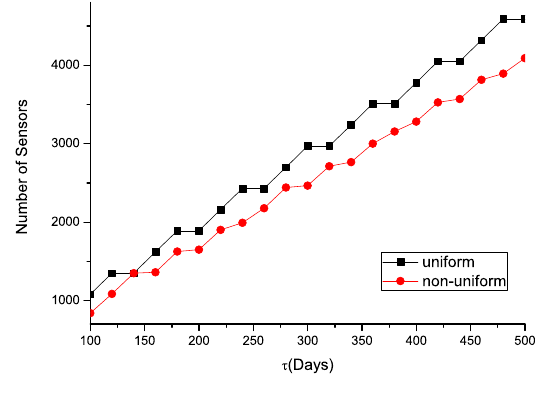
Figure 6. Optimal numbers of sensors deployed under different τ ∗ .